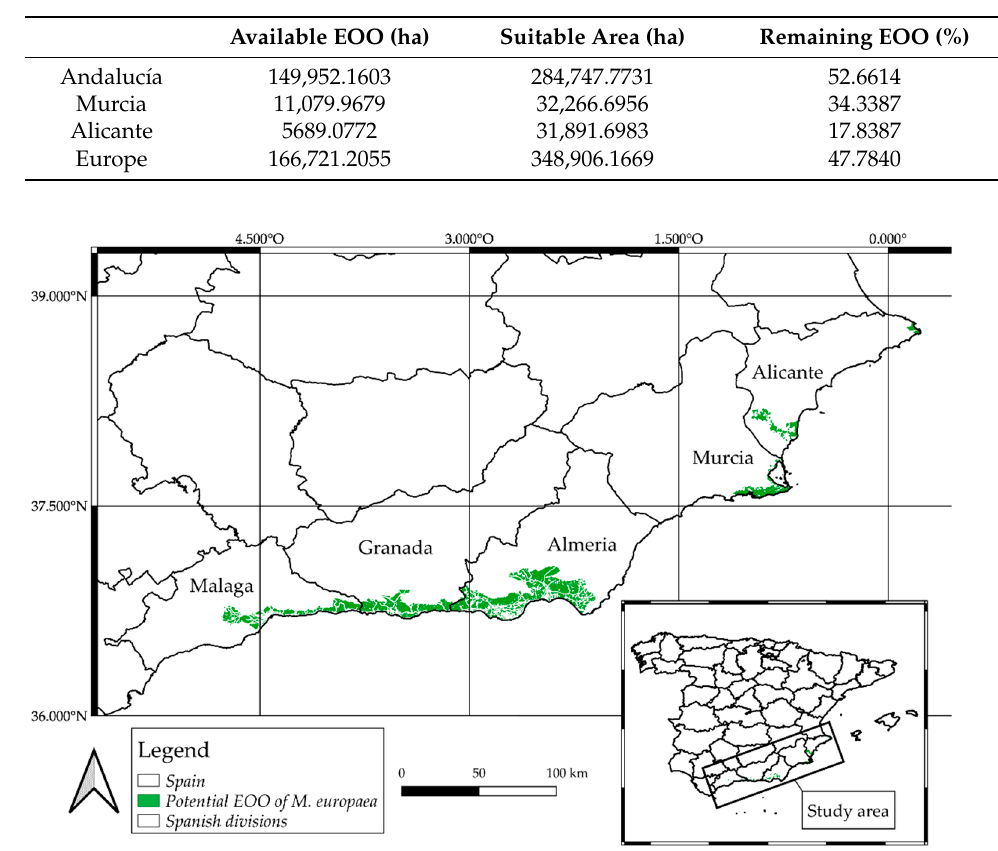
Figure 3. M. europaea potential extend of occurrence (EOO). Green polygons indicate available